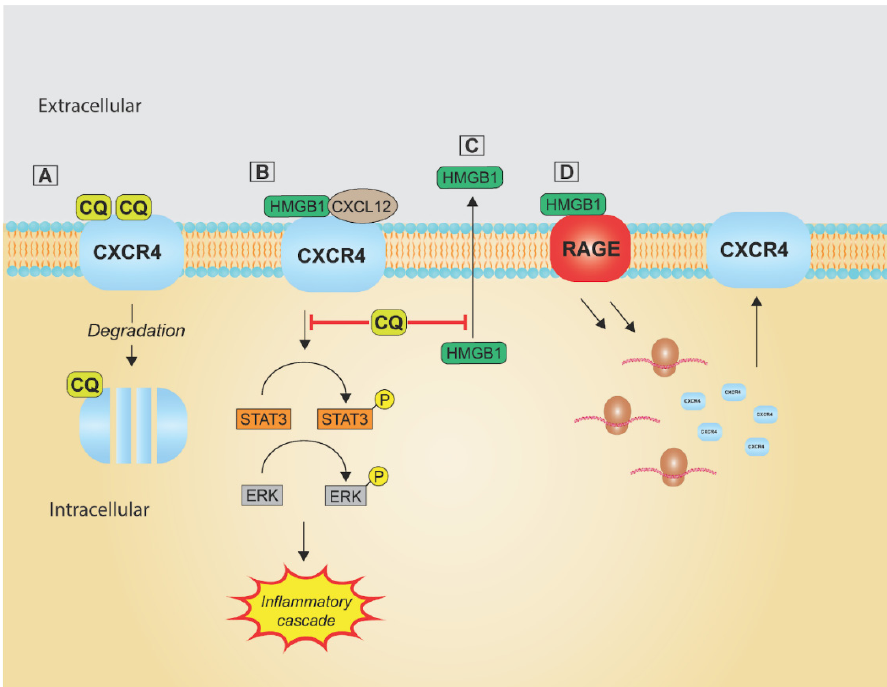
Figure 4. Inhibition of thrombus formation and NETosis. Thrombus formation driven by platelet- derived extracellular vesicles (PEVs) and antibody-induced platelet activation is inhibited by CQ. CQ also has a complex interference with NETosis, shown in the figure via inhibition of RAGE-me- diated autophagy, HMGB1 release, and activation of PAD4, NOX, and TLRs.